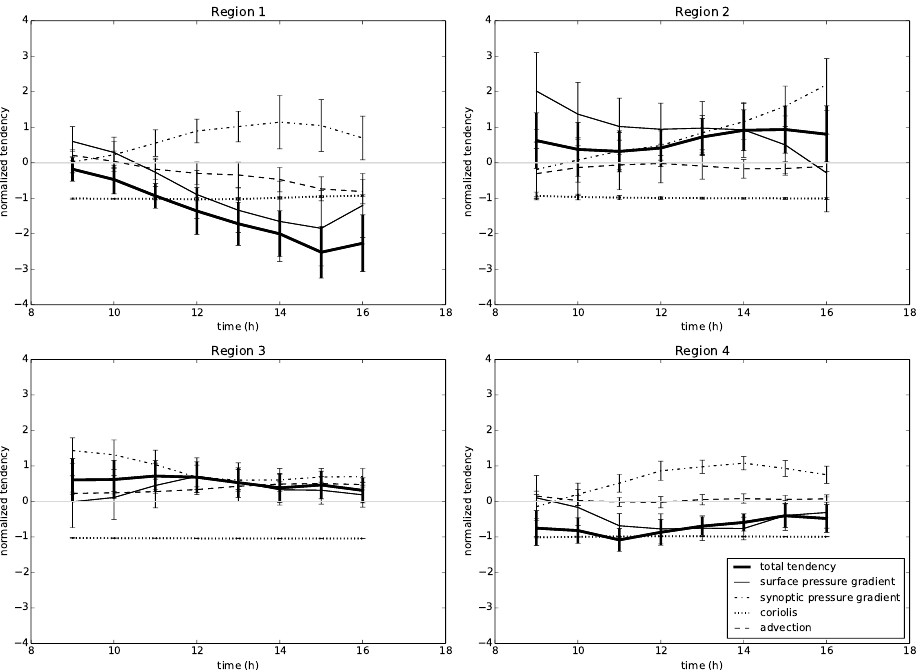
Figure 5. Evolution of dominant dynamic forcings for regions 1, 2, 3 and 4, on 20 June 1998. Positive and negative values correspond to ACR and CR,